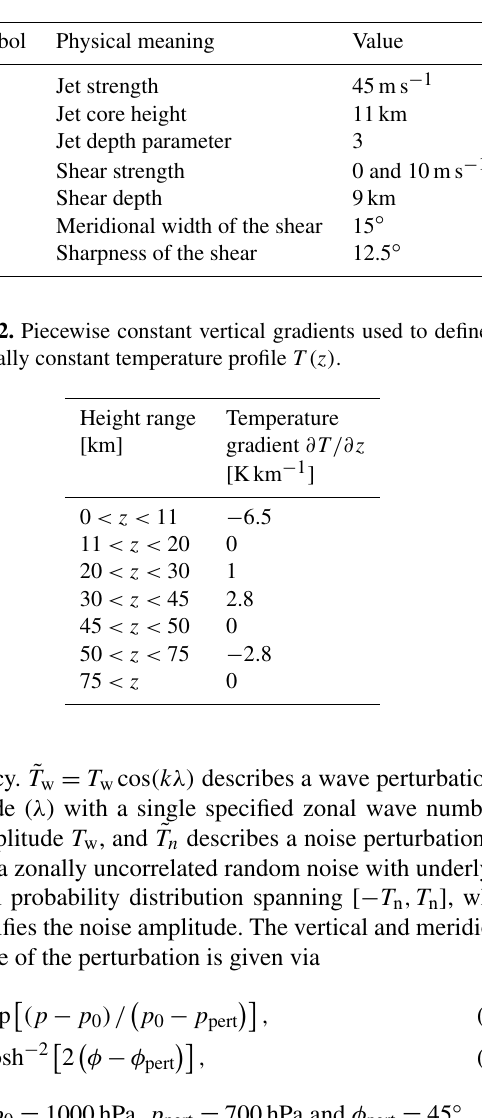
Table A1. Physical parameters used in the different model experi- ments.